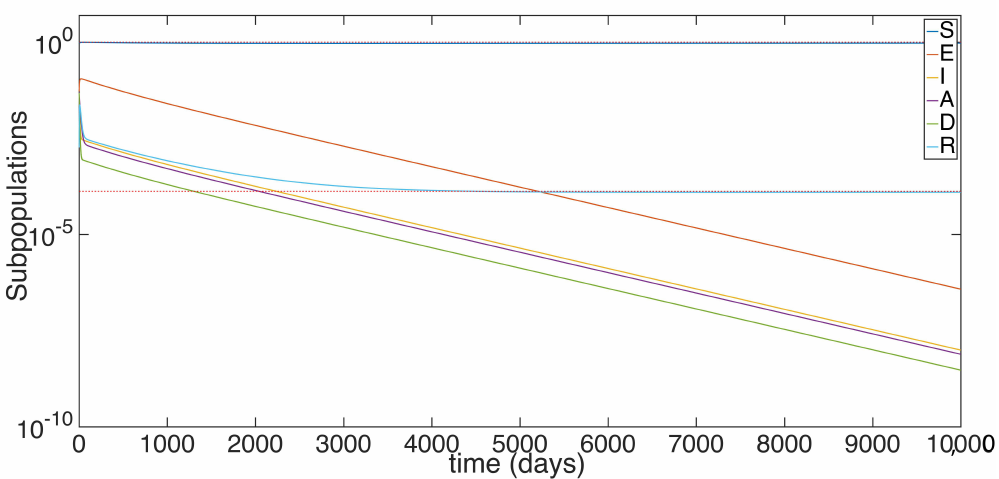
Figure 1. Time evolution of the different subpopulations for a R 0 =